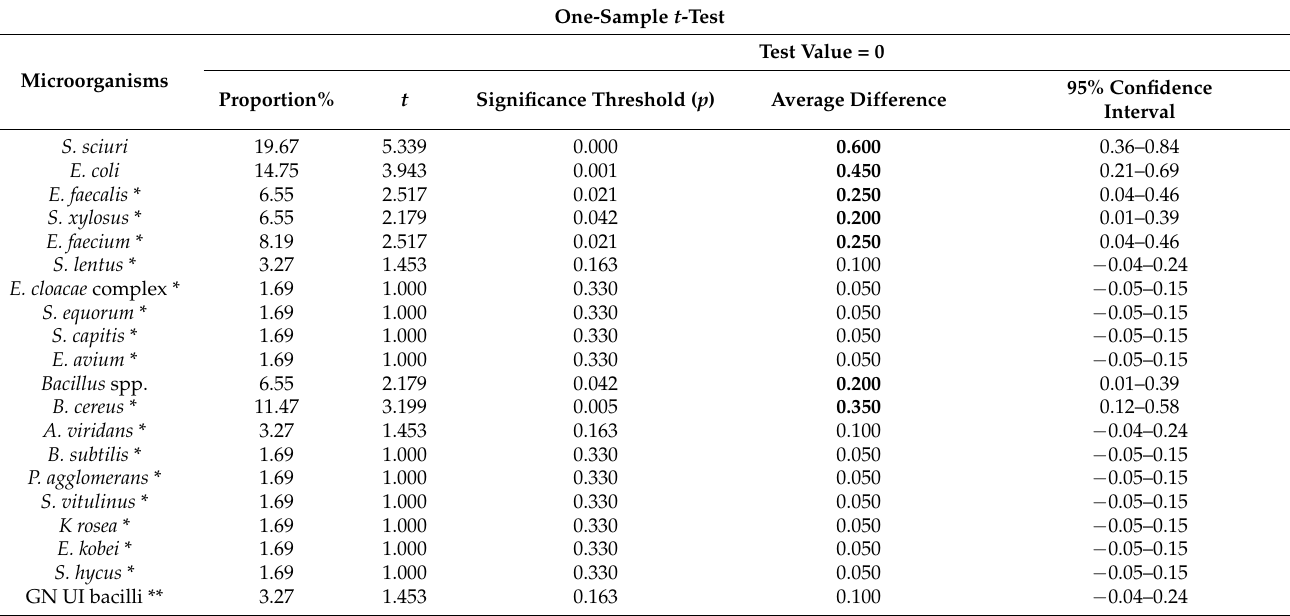
Table 2. The prevalence of the identified bacterial strains. One-Sample t